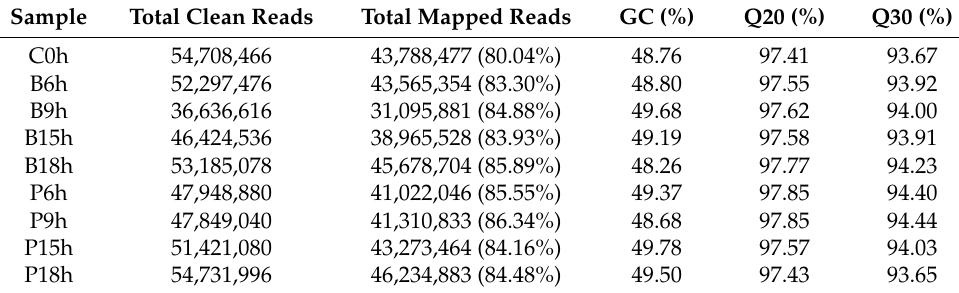
Table 2. The ratio of mapping to the tilapia genome. Sample